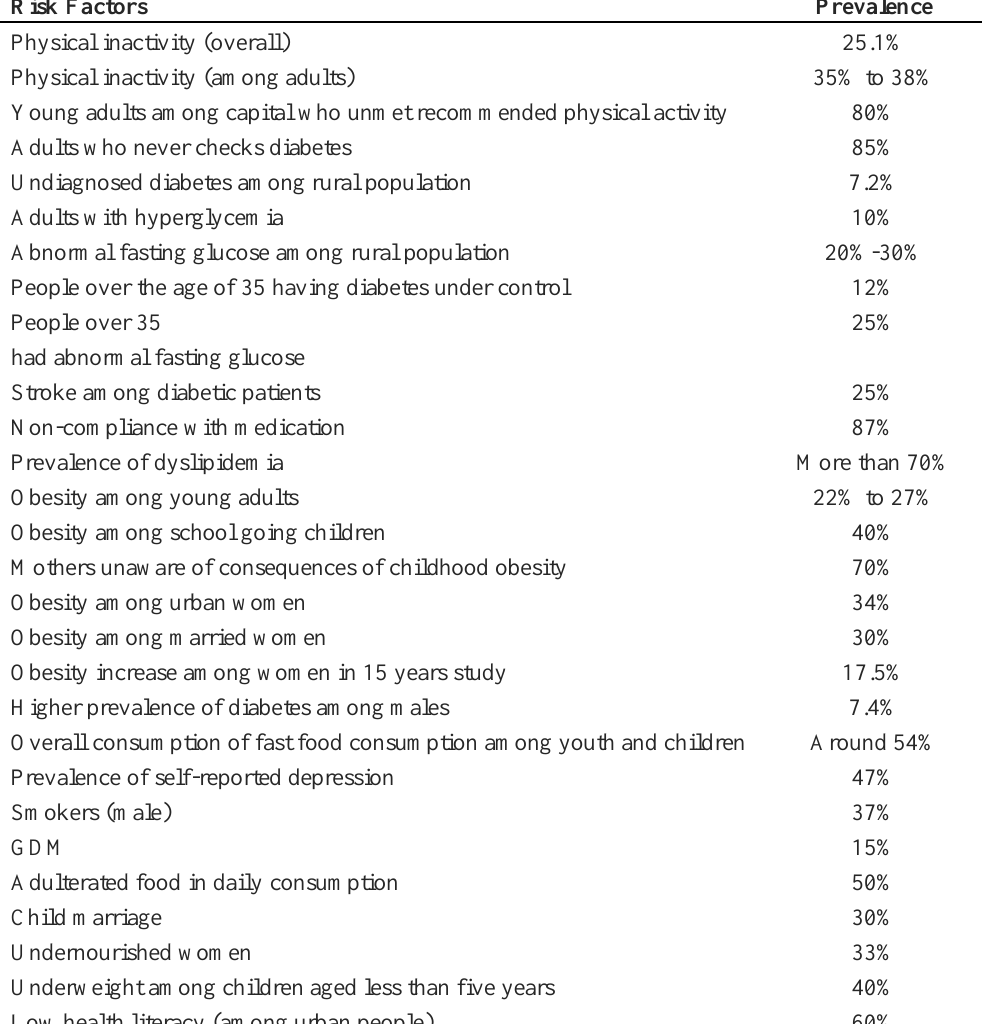
Table 1. Summary of Diabetic Risk Factors in Bangladesh ICDDR, B, estimated 150 food items in the country. More than 50% of the food samples they tested were adulterated reported by the Institute of Public Health (IPH) [17]. Undoubtedly human health is now under the domination of formalin, in Bangladesh about 400 tons of formalin is being imported which are goes to human stomach, creates deadly mistreats on long term